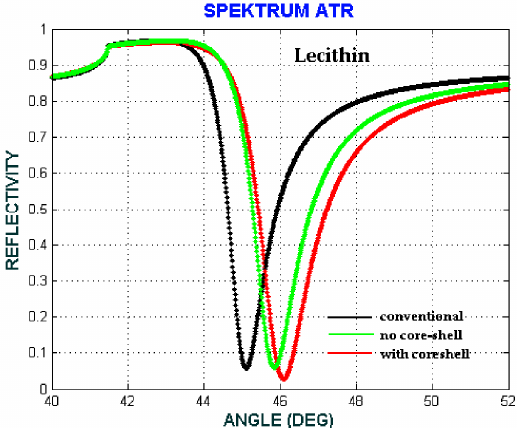
Figure 14. The ATR spectra for different configuration with the volume fraction of the composite F = 0.1, the size of the core-shell a = 2.5 nm and f = 0.73. (conventional: Prism/Ag/water/air, no core-shell: Prism/Ag/Hb Cytoplasm + water/air, with core-shell: Prism/Ag/Fe 3 O 4 @Au+Hb cytoplasm + water/air).